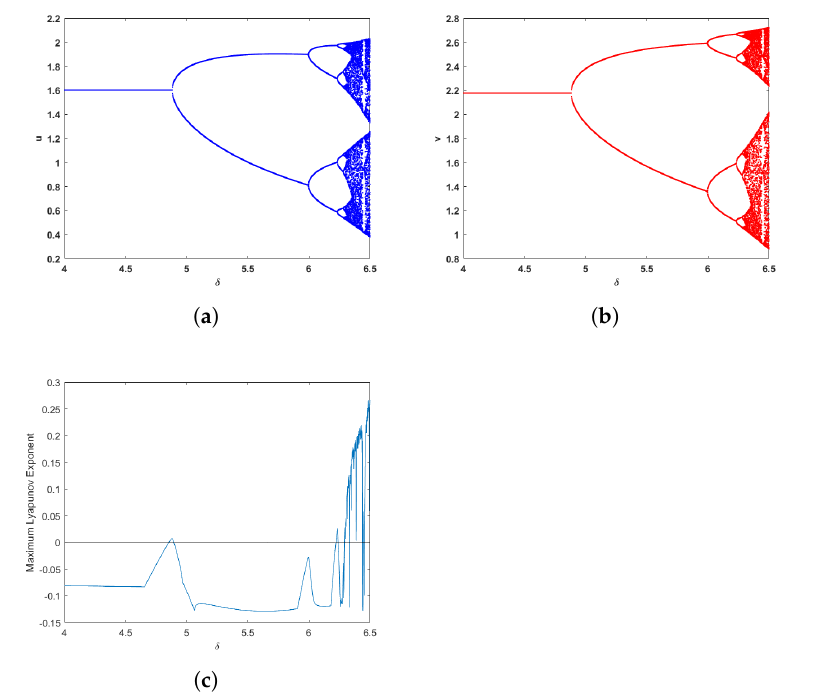
Figure 4. ( a , b ) Bifurcation diagram corresponding to u and v in system (2) with δ ∈ [4, 6.5], r 1 = 0.8, r 2 = 0.8, a = 0.4, b = 0.2, c = 2, d = 0.1, k = 5, h 1 = 0.06, h 2 = 0, the initial value is ( u , v ) = (3, 2).